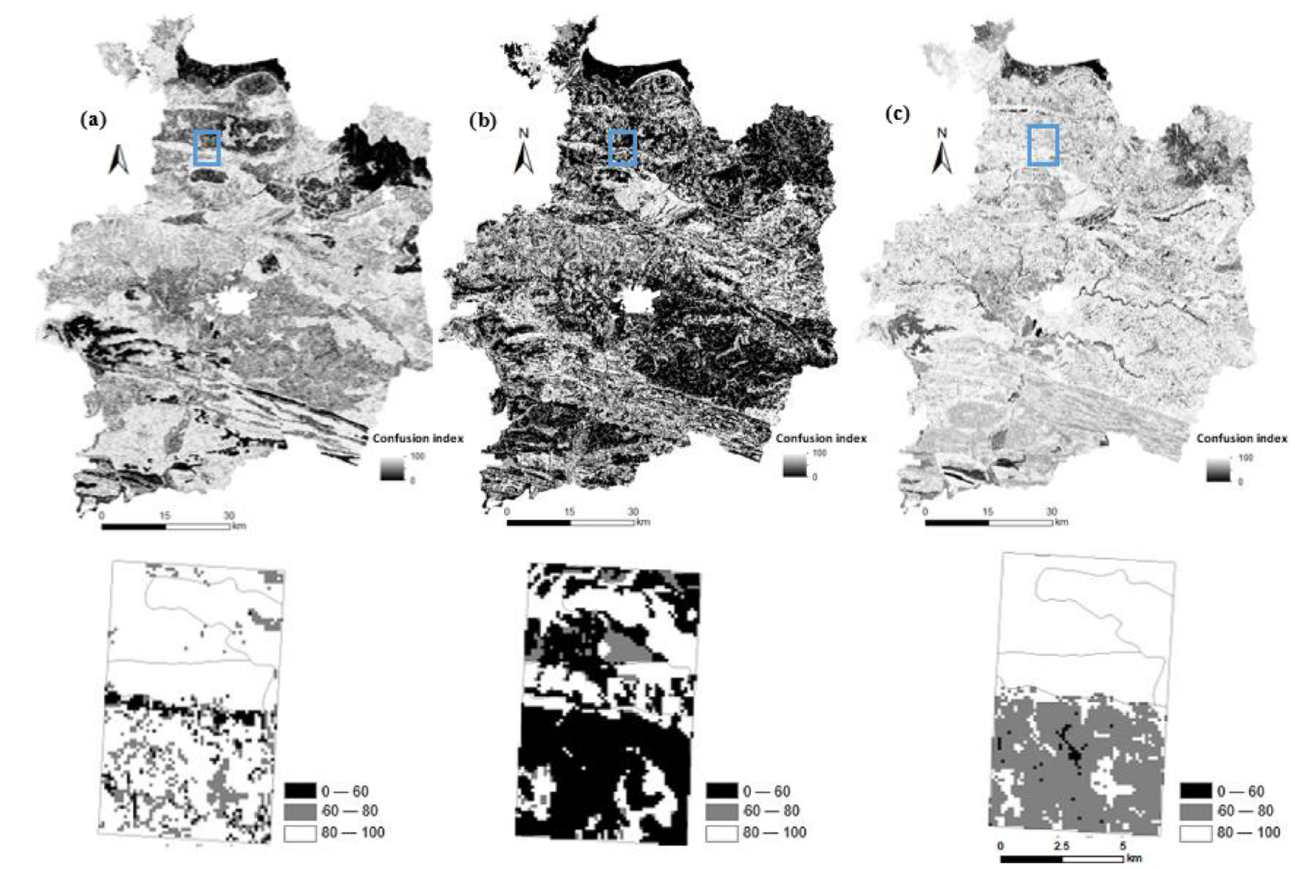
Figure 5. Confusion index maps for the (a) original DSMART approach, (b) DSMART with expert rules and (c) DSMART with extra soil